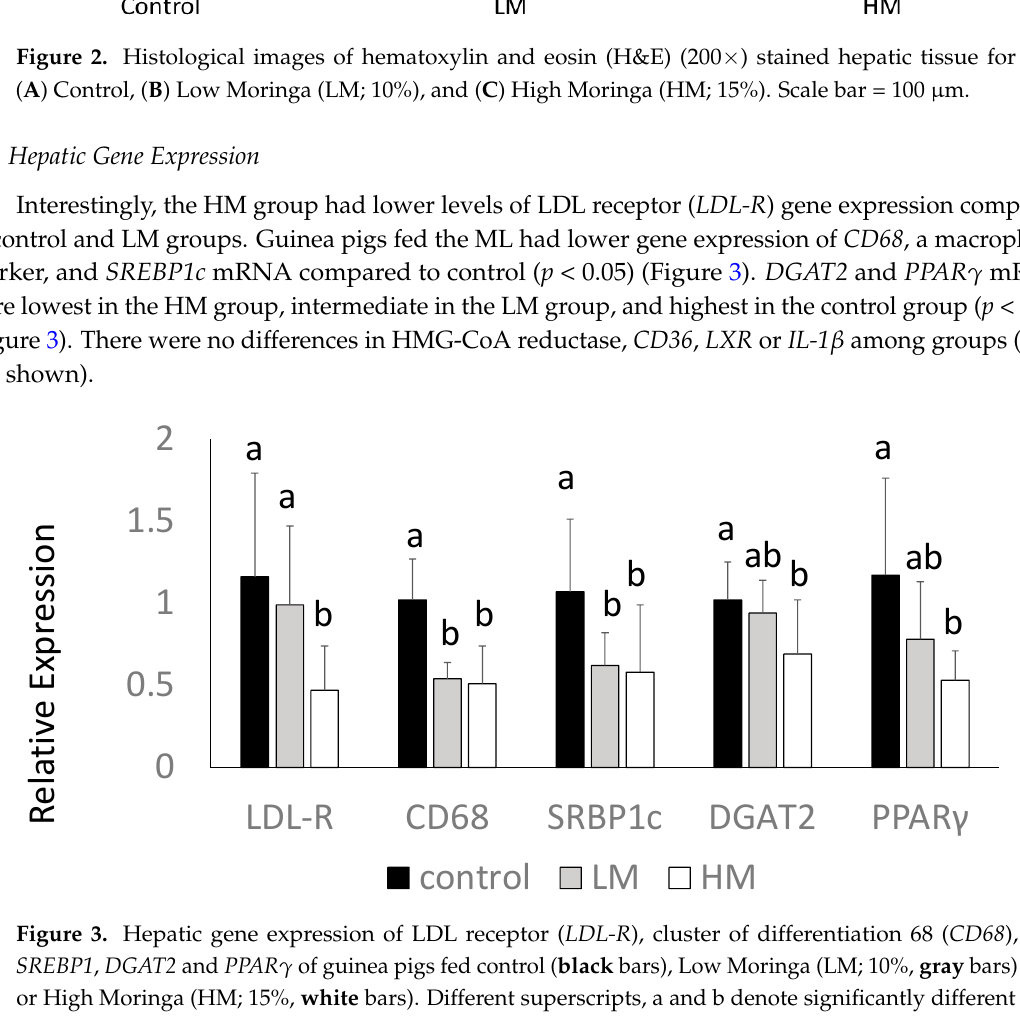
Figure 2. Histological images of hematoxylin and eosin (H&E) (100×) stained hepatic tissue for Control, Low Moringa (LM; 10%), and High Moringa (HM; 15%). Scale bar = 100 µm.